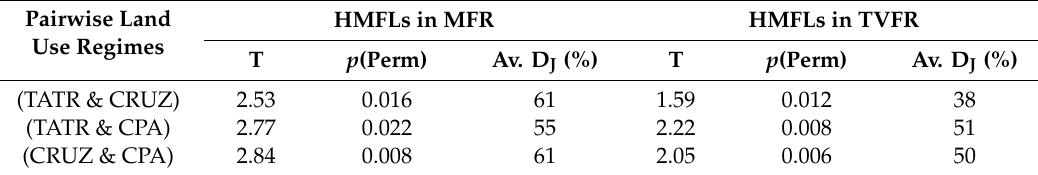
Table 4. Pairwise comparison of β -diversity gradient in human modified landscape (HMLF) in Mafhela and ThatheVondo Forest Reserves.